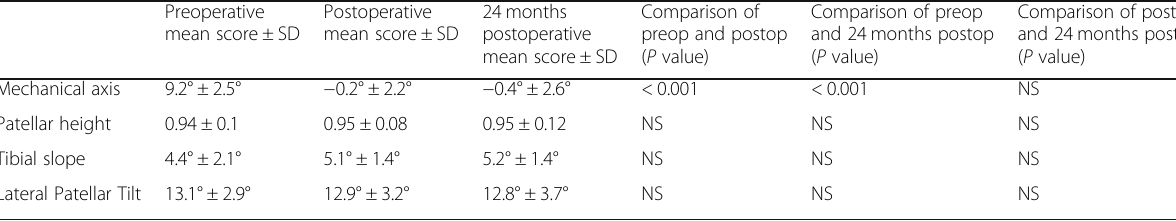
Table 1 Statistical analyses between preoperative and final follow-up